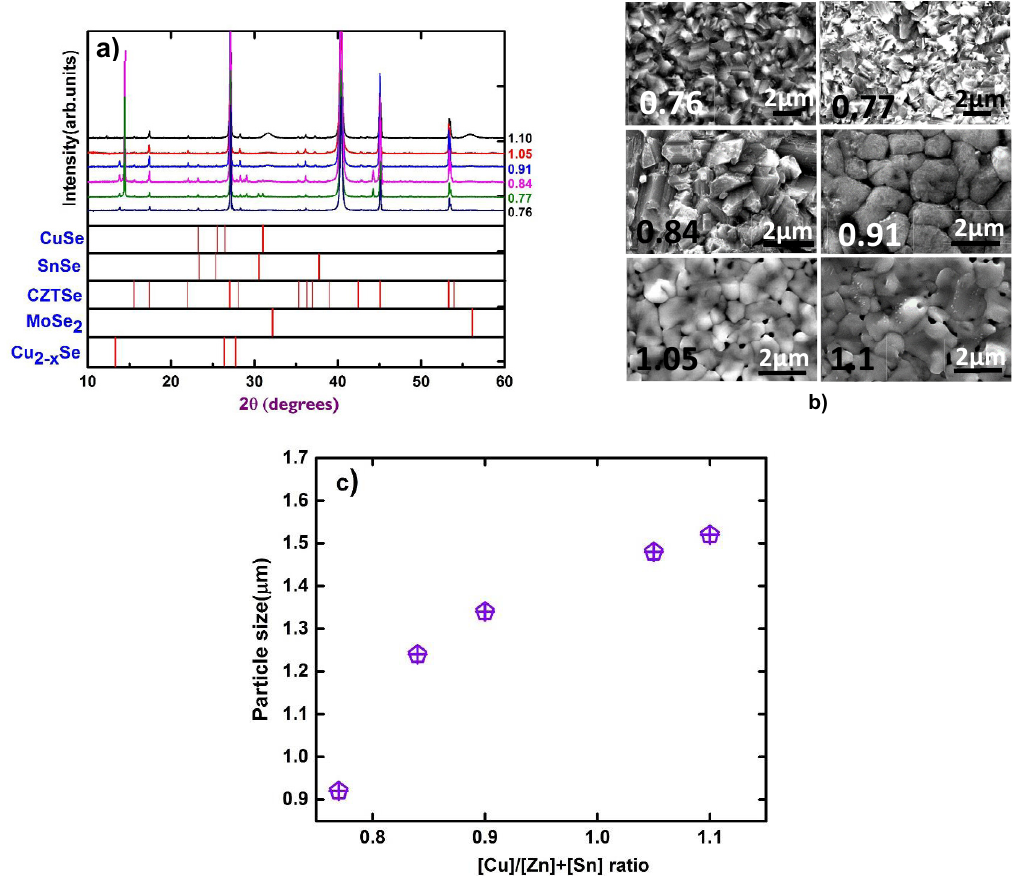
Fig. 2. (a) XRD spectrum of CZTSe absorbers with increasing [Cu]/([Zn] + [Sn]) ratios. (b) SEM Images of CZTSe absorbers with increasing [Cu]/([Zn] + [Sn]) ratios. (c) Evolution of particle size with increasing [Cu]/([Zn] + [Sn])